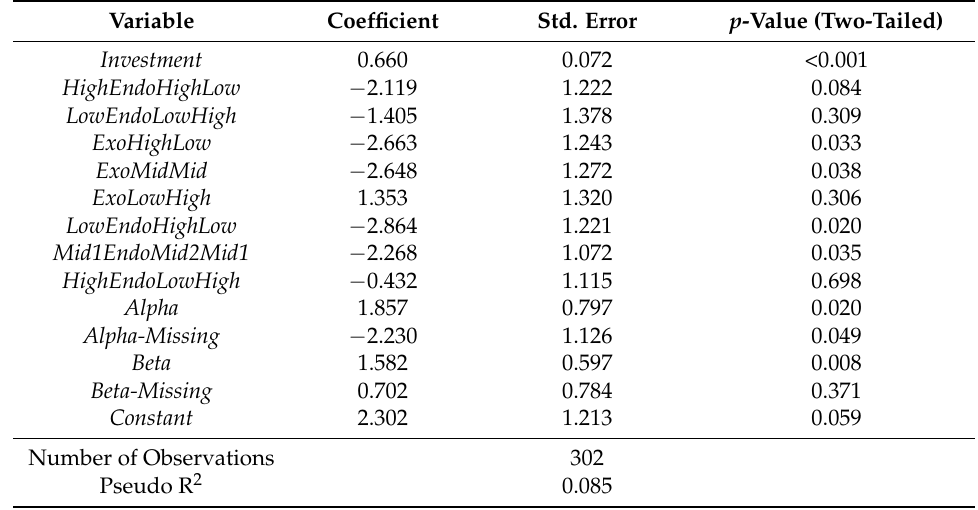
Table 4. Tobit Regression of Backtransfer (reference category for treatment is Mid1EndoMid1Mid2